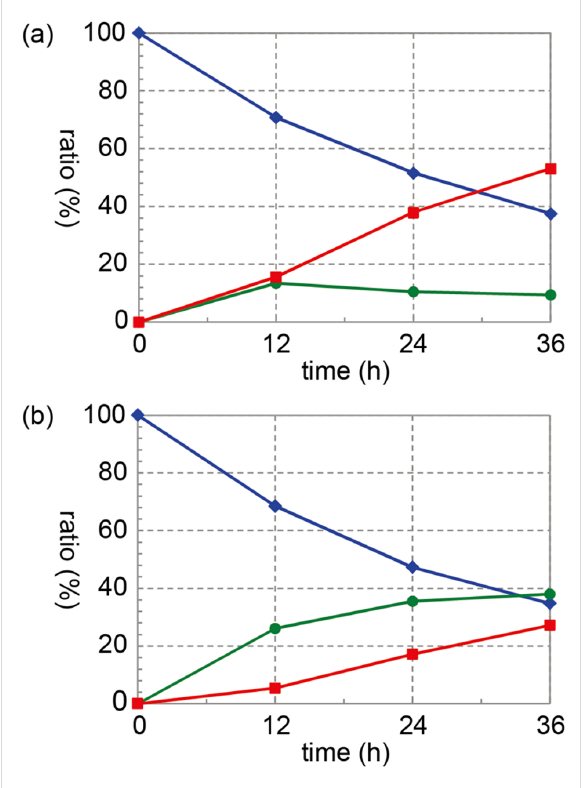
Figure 3: Reaction profile of the oxidation of (a) iodobenzamide 17 and (b) 2-iodobenzoic acid ( 3 ) with Oxone ® in the presence of Bu 4 NHSO 4 in a 4:1 mixture of CD 3 CN and D 2 O: monovalent iodine de- rivatives 17 and 3 (blue), trivalent iodine derivatives 27 and 28 (green), and pentavalent iodine derivatives 29 and 2